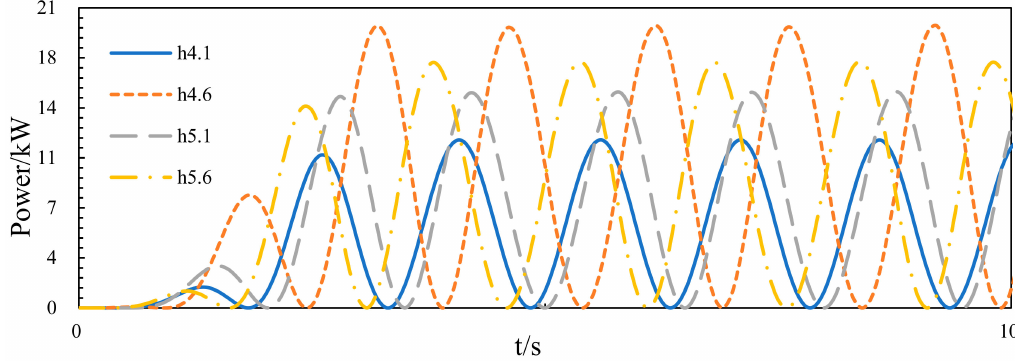
Figure 22. The instantaneous power curves of Buoy 2.